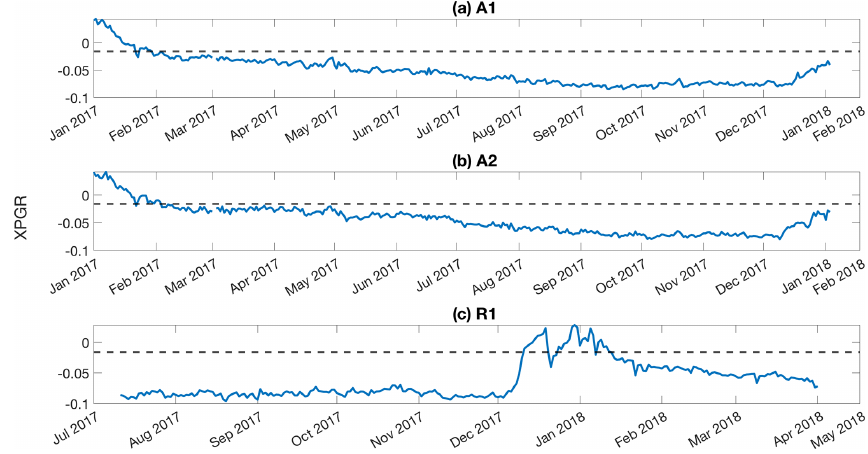
Figure 6. XPGR time series calculated with Eq. (1) over regions A1, A2 and R1 (shown in Fig. 1). This time series is an approximation of melt extent time series. The threshold above which the surface is assumed to undergo melt is − 0.0158 and is shown as a dashed horizontal line in each